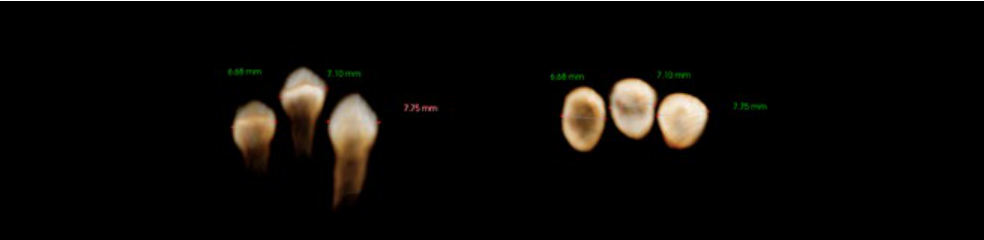
Figure 3. Occlusal and palatal view of the unerupted teeth with the final